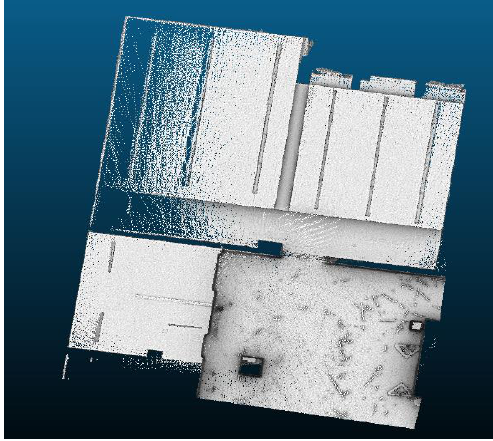
Figure 4. Manually extracted floor points as test data from the College of Engineering dataset.